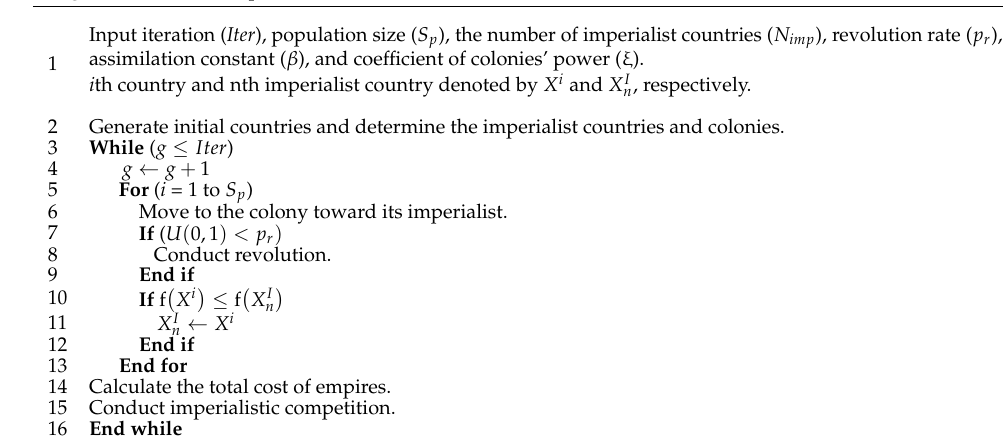
Algorithm 2: The ICA procedure